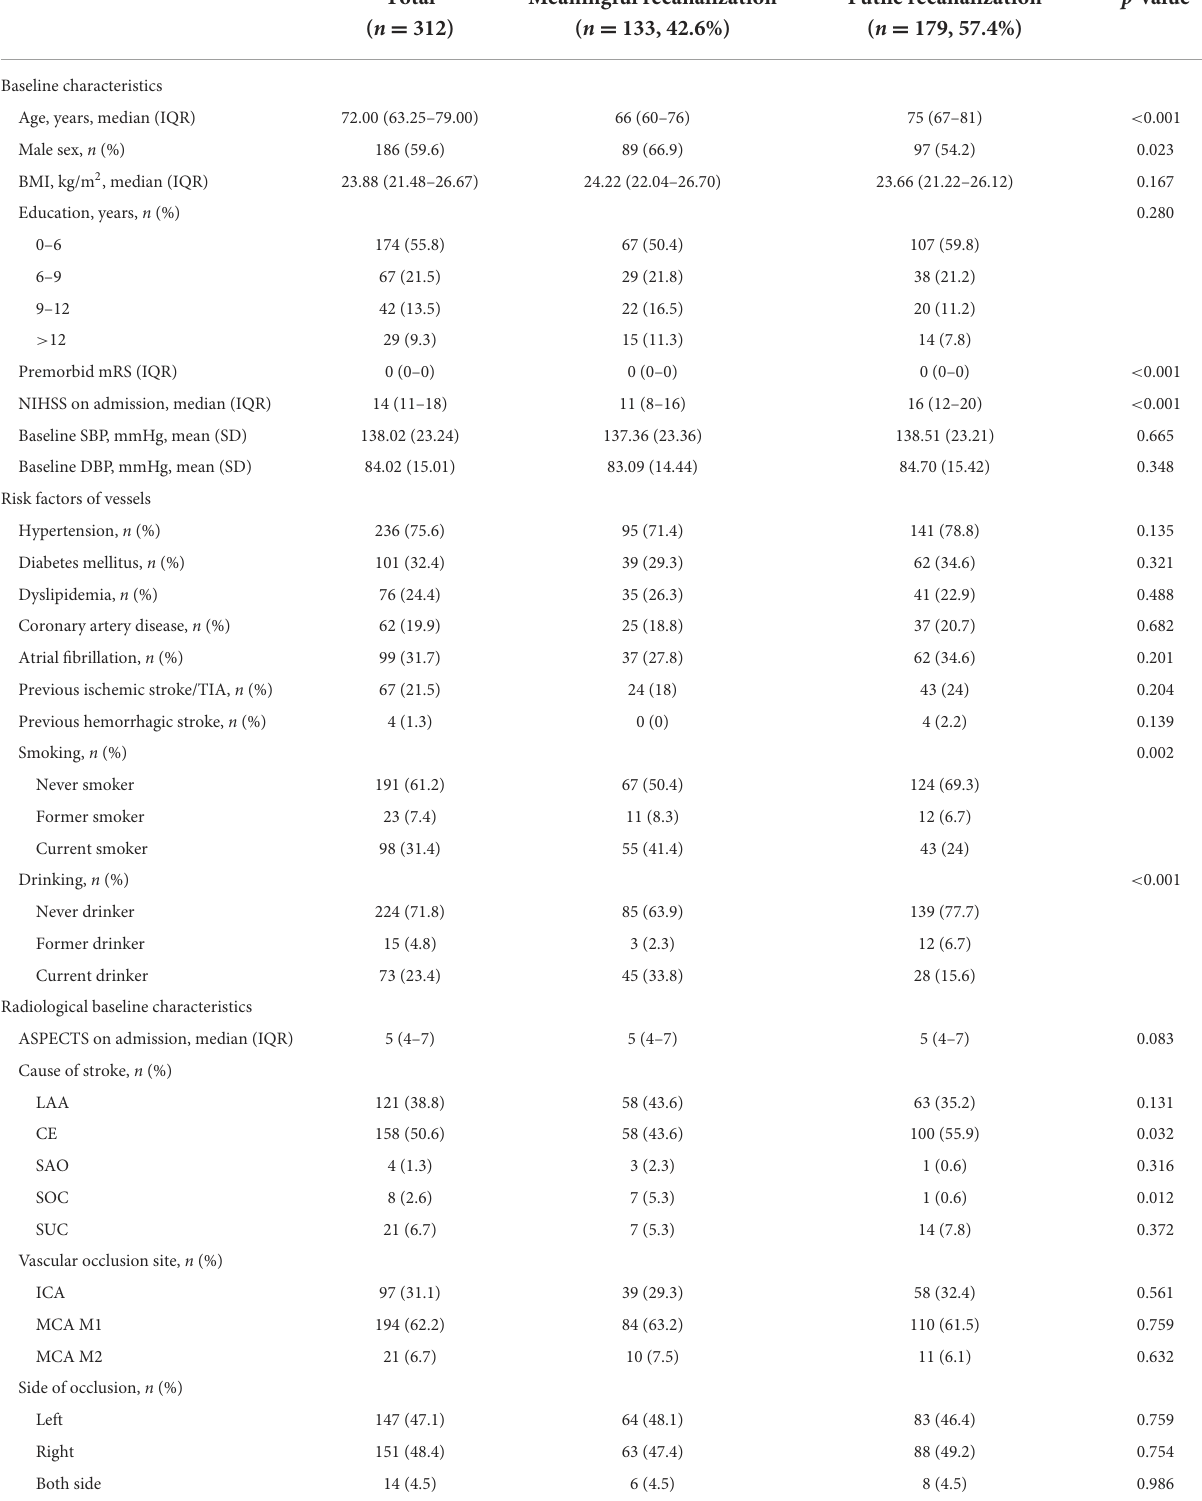
TABLE 1A Demographics and clinical